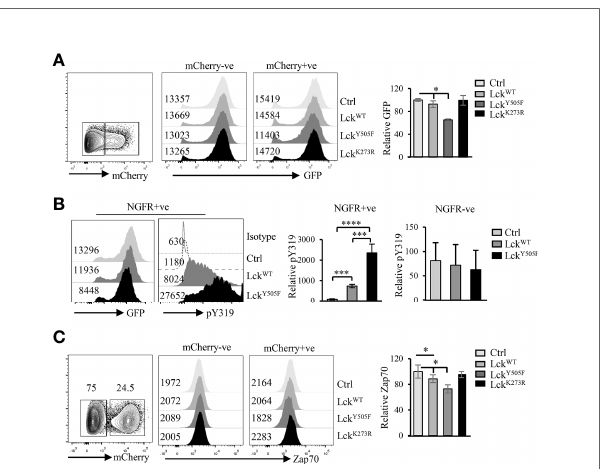
CA B FIGURE 3 | Elevated Lck activity negatively affects Zap70 expression. (A) 293T cells stably expressing hZap70-GFP fusion were transfected with plasmid expressing control, WT-Lck, constitutively active Lck Y505F or kinase- dead Lck K273R fused to mCherry. Histograms show GFP expression in mCherry-ve and mCherry+ve cells. Bar graph shows average of ratio of GFP expression in mCherry+/mCherry- cells normalized to that in control transfectants for three independent experiments. (B) Histogram shows a representative GFP expression and pY319 Zap70 staining in NGFR+ve 293T cells transfected with control, Lck WT or Lck Y505F plasmids. Bar graph shows an average of ratio of MFI for pY319 to GFP normalized to that for control transfectants in NGFR+ve and NGFR-ve cells from two independent experiments. (C) CD4 SP thymocyte cell line RLM was transduced with lentivirus expressing control, WT-Lck, constitutively active Lck Y505F or kinase- dead Lck K273R fused to mCherry. Zap70 expression in RLM cells expressing or not mCherry was determined. A representative histogram for Zap70 staining in mCherry- and mCherry+ cells is shown. Bar graph shows average of ratio of mCherry+/mCherry- cells normalized to control for three independent experiments. Error bar represents S.D * p < 0.05, ***p < 0.0005, ****p <